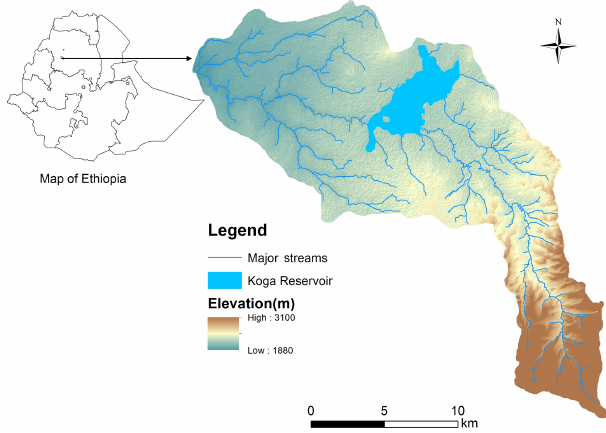
Figure 1. Location map of the Koga watershed showing an eleva- tion